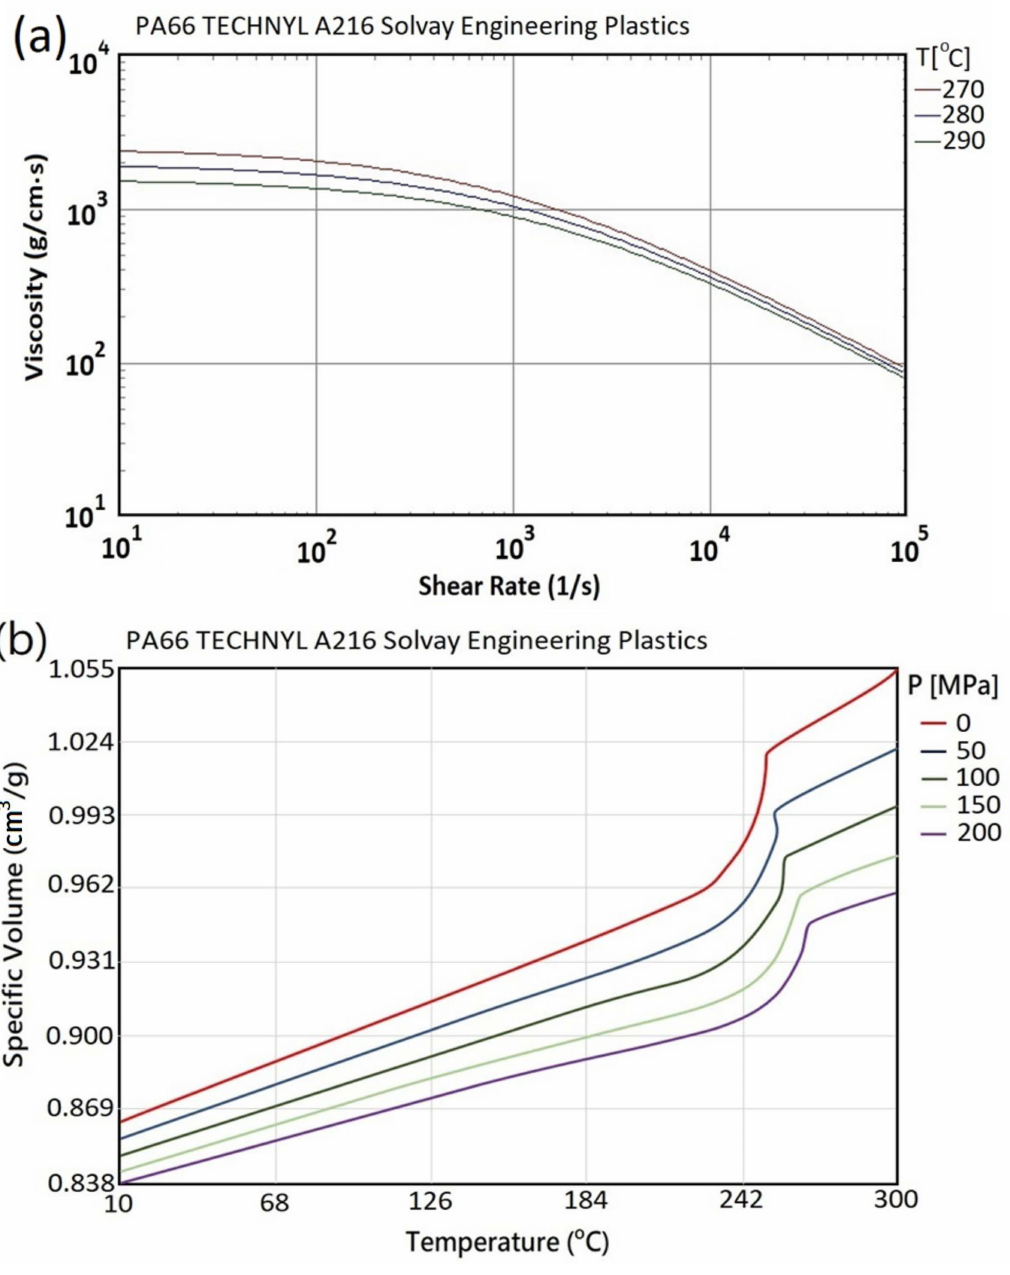
Figure 4. ( a ) Viscosity and ( b ) P- v -T properties of PA66 material (Source: Moldex3D material